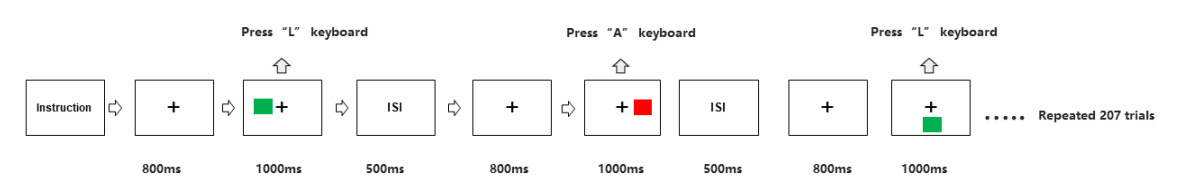
FIGURE1 Experimental procedure of Simon task. The green or red square was presented on right, left or below side of the fixation on the computer screen. For the green square, participants had to press the “L” keyboard with right hand. For red square, participants had to press the “A” keyboard with left hand.ISI, inter-stimulus